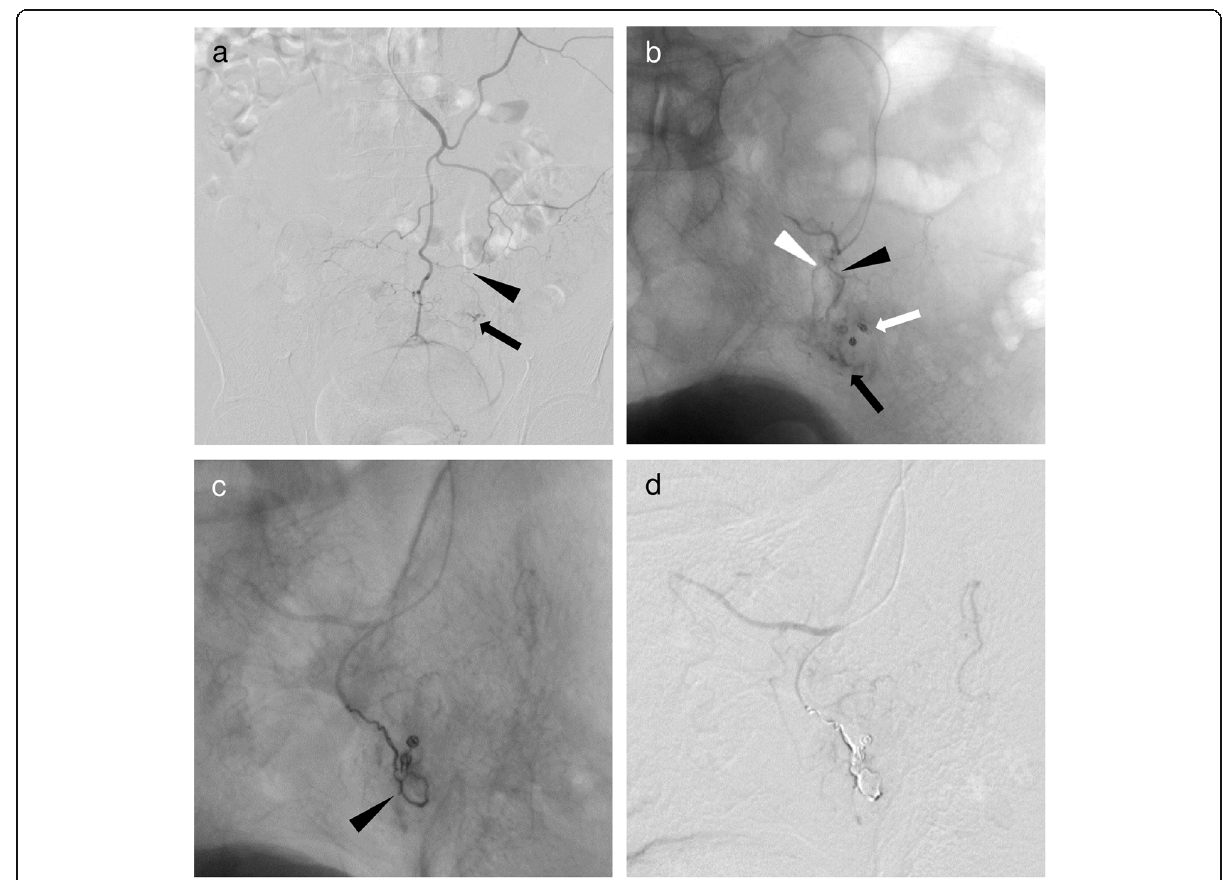
Fig. 3 A 63-year-old man with sigmoid colonic hemorrhage due to colon cancer. Ultraselective TAE was performed after hemostatic clipping via colonoscopy was unsuccessful. a Inferior mesenteric angiography showed a small and considerably bent vasa recta (black arrowhead) of the sigmoid artery with contrast extravasation (black arrow) at the distal end. b Superselective angiography through the vasa recta (long branch, black arrowhead; short branch, white arrowhead) of the sigmoid artery with a 1.7-F microcatheter (Progreat λ 17; Terumo) showed contrast extravasation (black arrow) at the distal end of near clipping (white arrow). After identifying the bleeding site, a 1.7-F microcatheter was inserted into the long branch of the vasa recta as close as possible to the bleeding site (not shown). c Ultraselective angiography through the long branch of the vasa recta showing a microcoil (Galaxy G3 Microcoil; Codman & Shurtleff. Inc.) of 3 mm in diameter and 8 cm long, and two microcoils of 2 mm in diameter and 2 cm long (black arrowhead) placed at the site of contrast extravasation and the bleeding branch. d After ultraselective TAE, contrast extravasation had completely